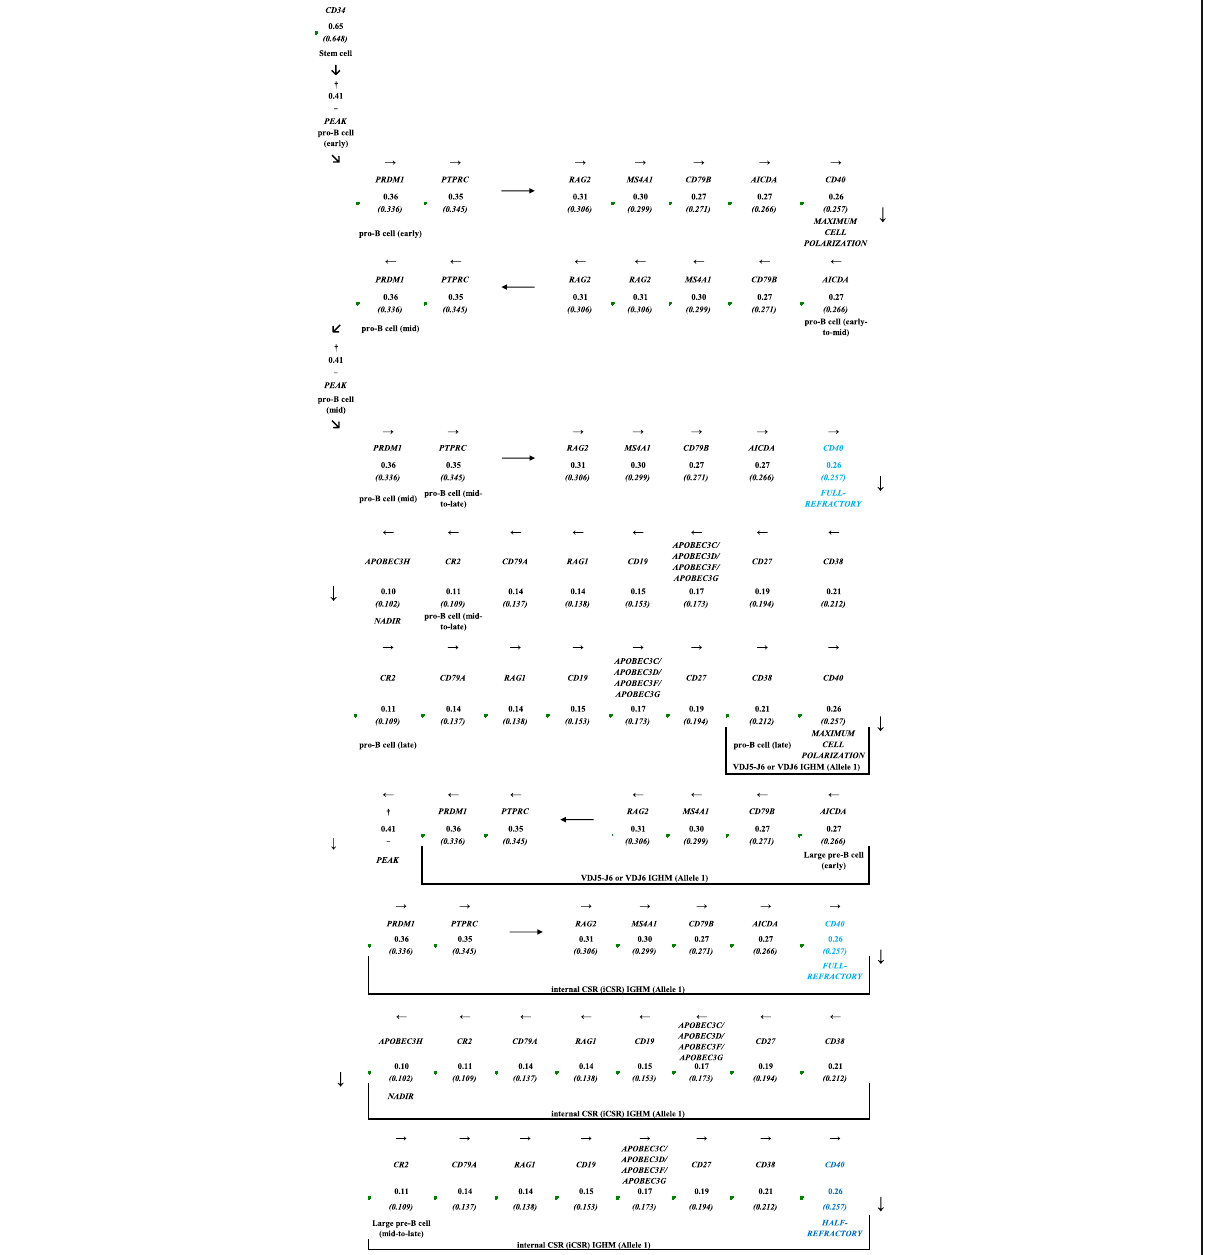
Fig. 1 Pressuromodulation map of B-cell differentiation stages. There are three completed maximal B-cell polarization periods with another to begin (CD40R+), two half-refractory B-cell polarization periods (CD40R±), and four full-refractory B-cell polarization periods (CD40R-) to the 1st generation CM VDJ (VJ)-IgG3+, IgG1+, IgHA1+, IgG4+, IgG2+ or IgE+ (excluding IgA2+) Evolved Mature naïve B-cell preparing to CSR further in the lymph node (2nd phase) after the completing the Immature B-cell phase in the myeloid bone marrow (1st phase). The antigen pressuromodulation effect- mediated extra-lymph nodal long-lived B-plasma cell/plasmablast secretory antibody phase (3rd phase) takes place in the periphery/tissue nidus. Note: The classical pathway B-cell maturation pressuromodulation map is shown, however the map applies to the parallel alternate B-cell maturation path- way wherein the T-cell independent antigen-mediated toll-like receptor (TLR) positive pressuromodulation effect (i.e. endocytic) substitutes for the CD4R+ CD40LG T-cell-mediated CD40R B-cell polarization pressuromodulation effect. † , upper esebssiwaagoT Q units range, 0.41 – 0.36. Black, CD40 at maximum cell polarization potential (CD40R+). Dark blue, CD40 at half-refractory (CD40R±). Light blue, CD40 at full-refractory (CD40R-). Thick black lined large rectangu- lar box, extra-nodal secretory antibody